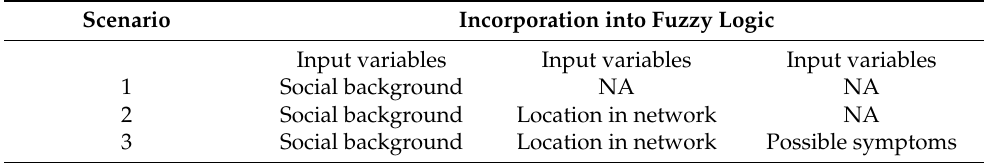
Table 2. Three different scenarios for a sensitivity analysis. Each scenario incorporates an additional input variable into the fuzzy logic system in order to determine the consumer agents’